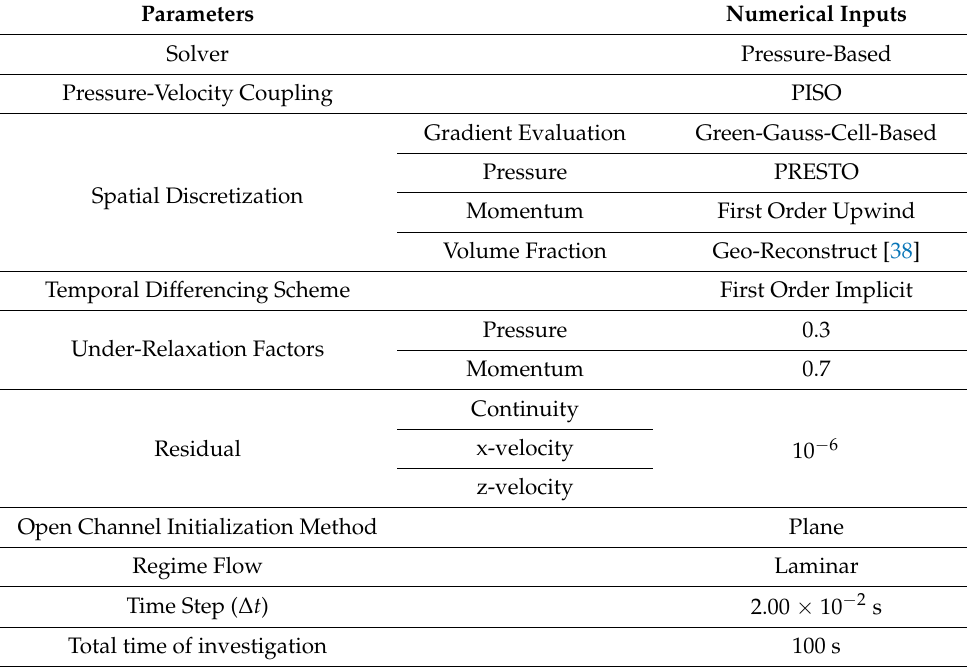
Table 4. Methods and parameters used in the present numerical